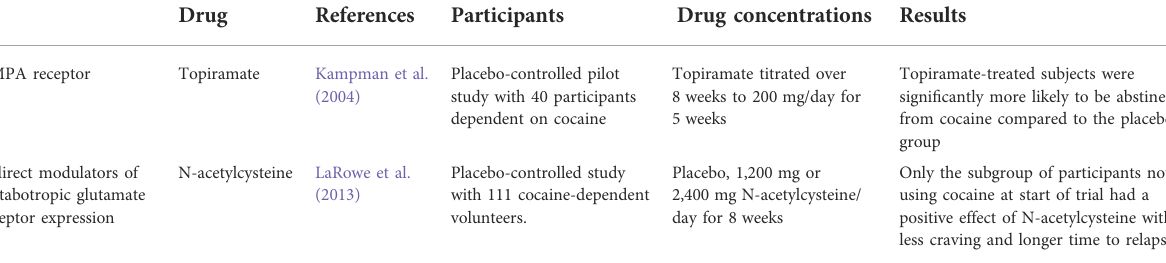
TABLE 2 Human studies with pharmacological targeting of the glutamate system to treat psychostimulant addiction.